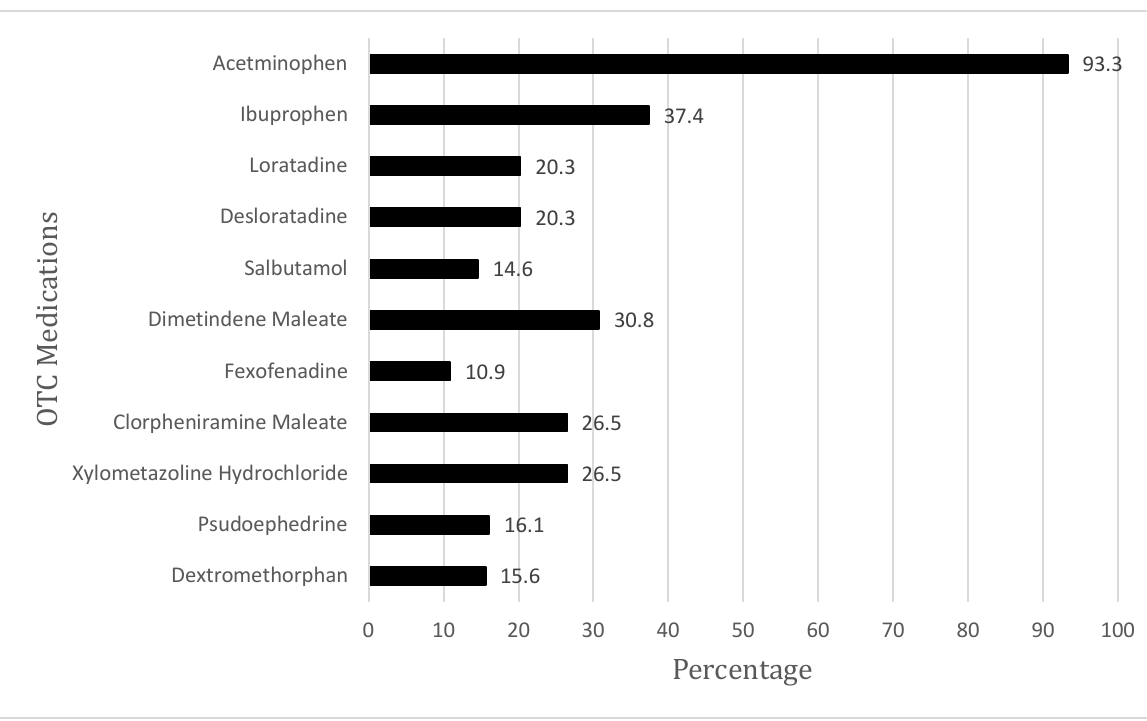
Figure 2. OTC medications that are commonly used by parents.